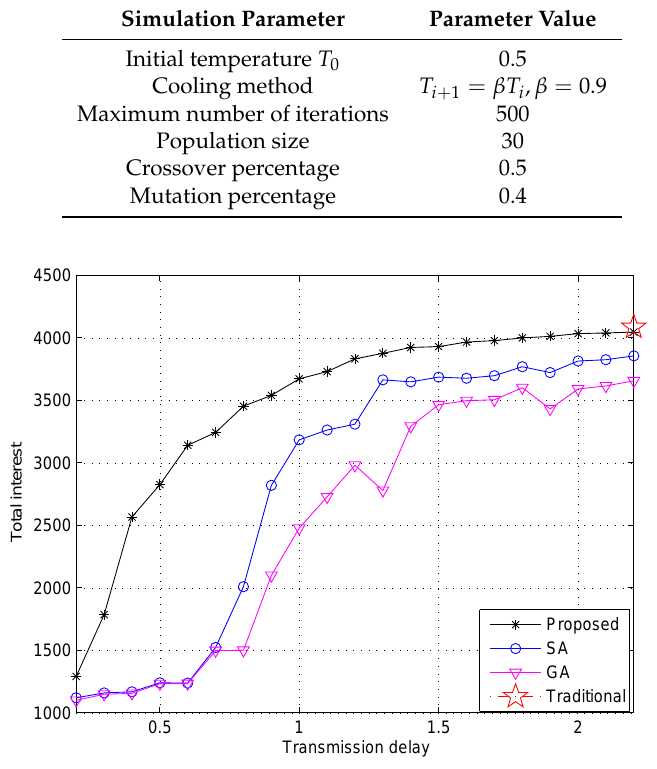
Figure 6. The total user interest as a function of the transmission delay with different algorithms ( P T = 2 W , ξ = 0.9 and λ =